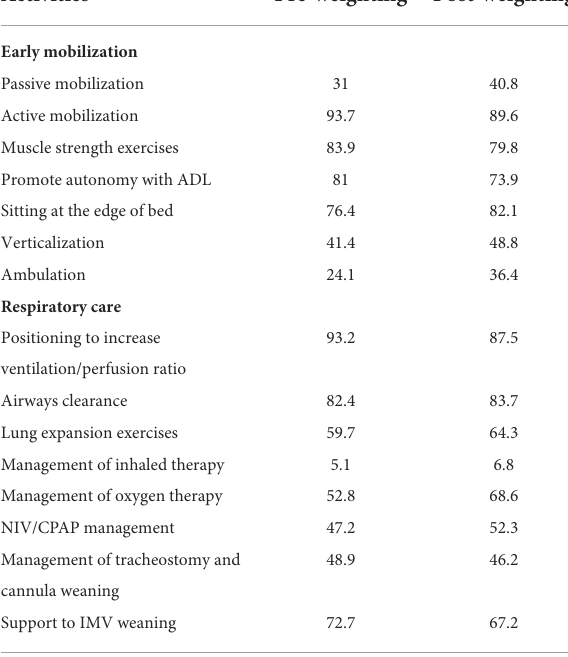
TABLE 3 Respiratory physiotherapy intervention ( n =